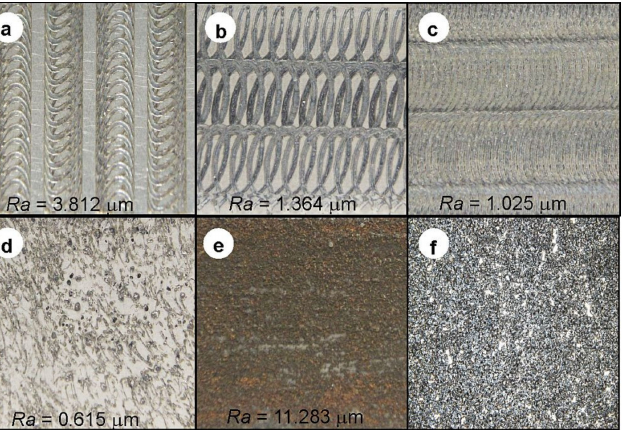
Figure 3. View of modified heated plate surfaces produced by: ( a – c ) vibration-assisted laser texturing,